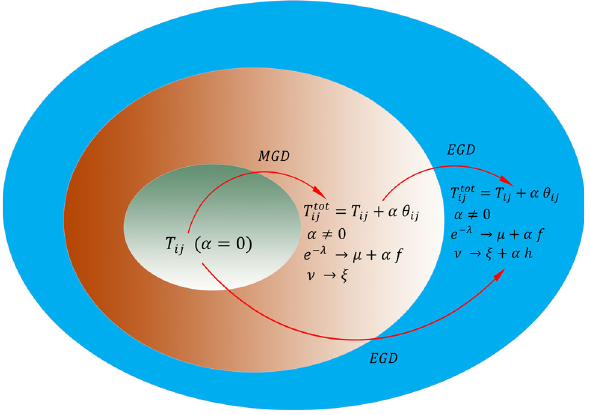
Fig. 1 This diagram shows that how any perfect fluid matter distribu- tion can be consistently extended into the anisotropic domain though the MGD-decoupling as well as CGD-decoupling